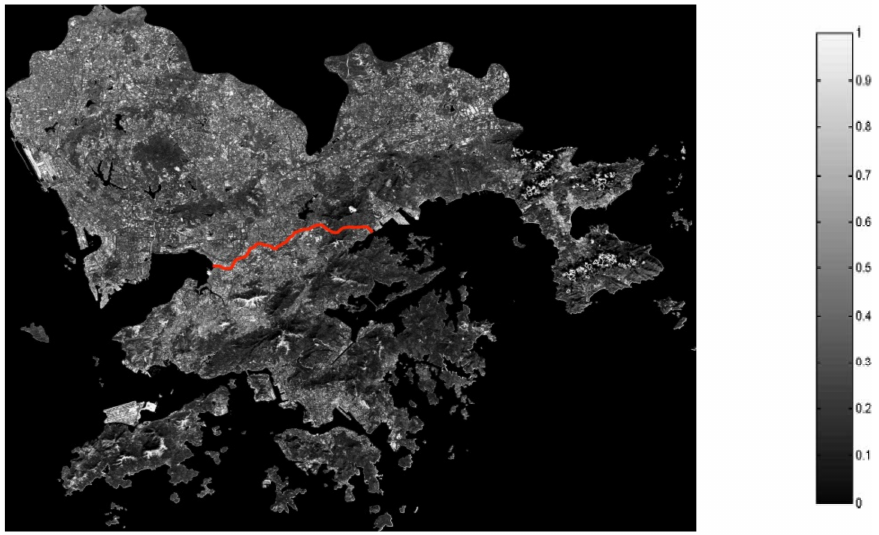
Figure 10. RMSE (root mean square error) results in